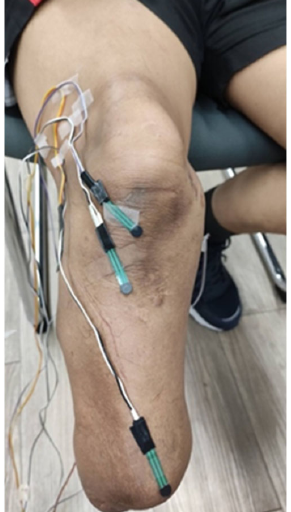
Figure 3. An example of force sensing resistor sensor placement on a residual limb.